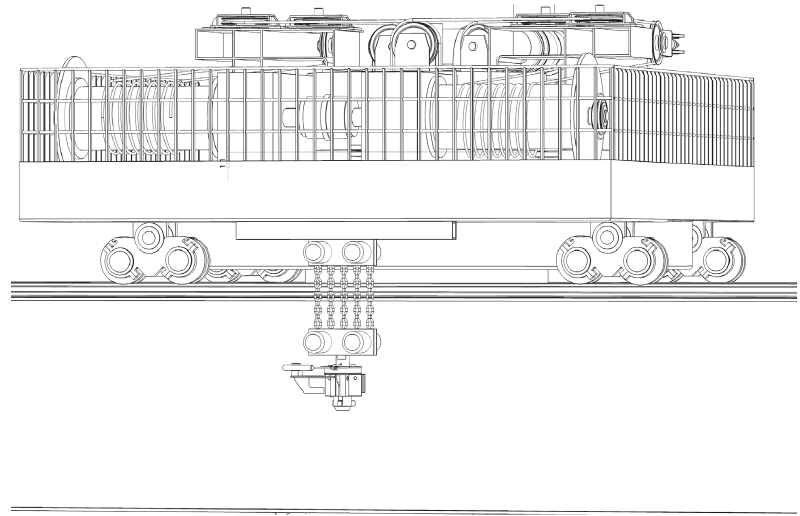
Figure 8: Schematic drawing of the ground